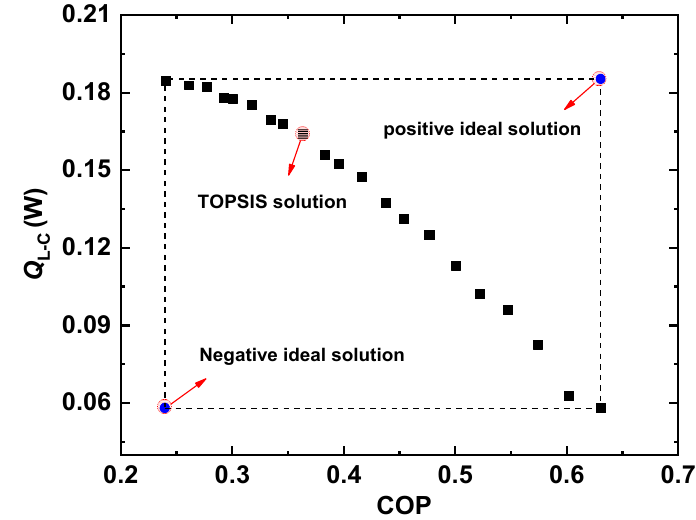
Figure 8. The set of trade-off solutions over Pareto front with ideal solution selected by TOPSIS.